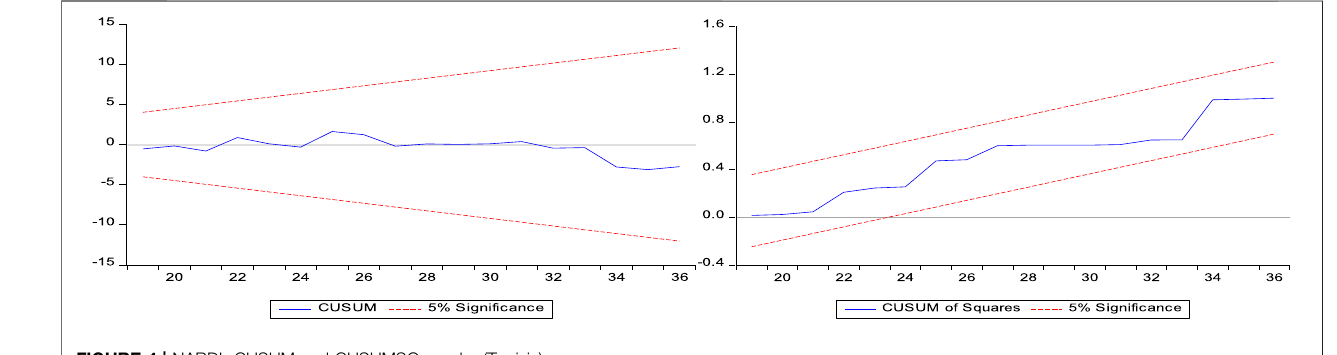
FIGURE 4 | NARDL CUSUM and CUSUMSQ graphs